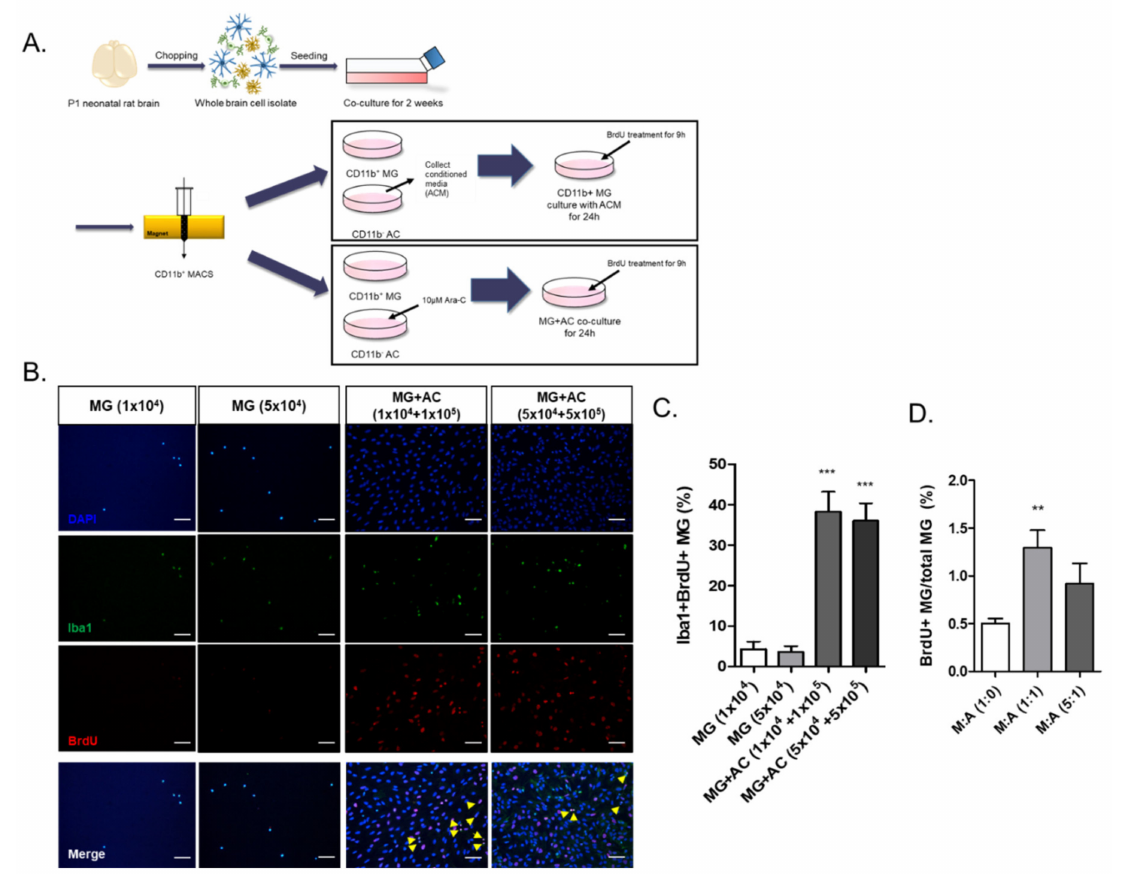
Figure 3. Astrocytes directly increased microglial proliferation: ( A ) the experimental scheme of microglial co-culture with astrocytes and treatment of ACM; ( B ) the BrdU-incorporation assay for the MG d14 co-cultured with astrocytes. Yellow arrowhead: Iba-1 + BrdU + cells; ( C ) the quantitative data of the percentage of BrdU + cells under co-culture of astrocytes ( n = 5); ( D ) quantitative data of the percentage of BrdU + cells under treatment of ACM to MG d14 ( n = 5). ** p < 0.01, *** p < 0.001, n = 3; scale bar = 100 µ